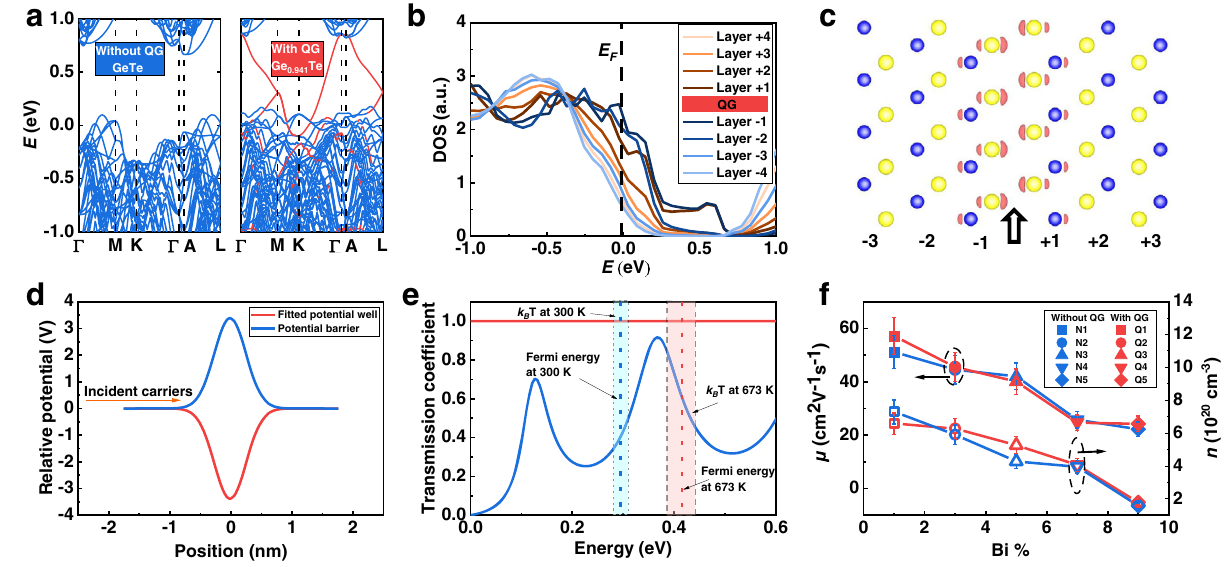
Fig. 3 | Theoretical analysis and experimental veri fi cation of the role of QG in electricalconductivity.a The band structure of GeTe with and without QG. The red color indicates the band states near QG. b Layer-resolved DOS of GeTe with QG. c The partial charge density around QG within the energy range of E F ±5 k B T